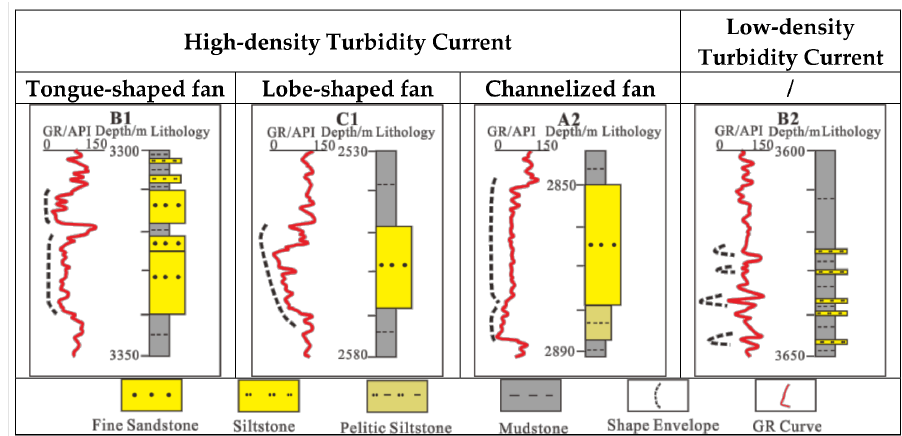
Figure 6. Logging curve characteristics of high- and low-density turbidite deposits. See Figure 1C for the locations of these wells.